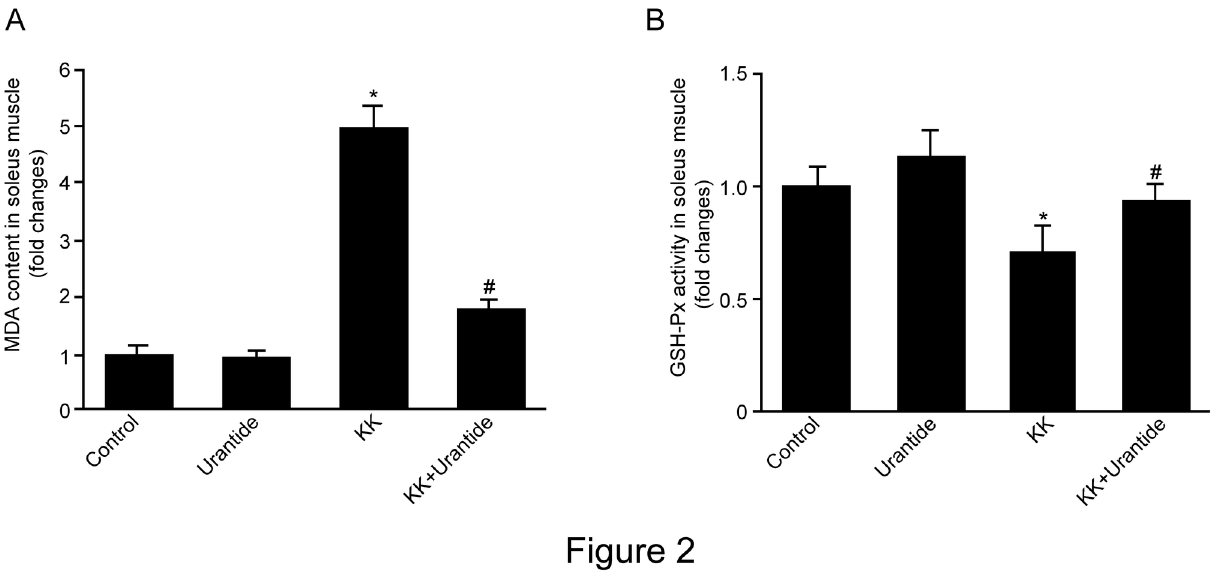
Figure 2. Effect of urantide on MDA content and GSH-Px activity in soleus muscle in mice. KK mice were administrated urantide (30 µg/kg/day) for 14 days prior to measurement of ( A ) MDA content by thiobarbituric acid assay and ( B ) GSH-Px activity using a Glutathione Assay Kit. Control (C57BL mice were treated with saline for 14 days), Urantide (C57BL mice were treated with urantide for 14 days), KK (KK mice were treated with saline for 14 days), KK+Urantide (KK mice were treated with urantide for 14 days). Control: C57BL/6J mice were treated with saline for 14 days; Urantide: C57BL/6J mice were treated with urantide for